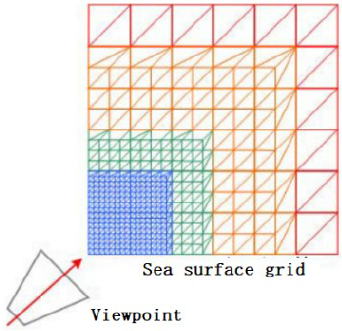
Figure 4. Adaptive division of the ocean surface grid for phase